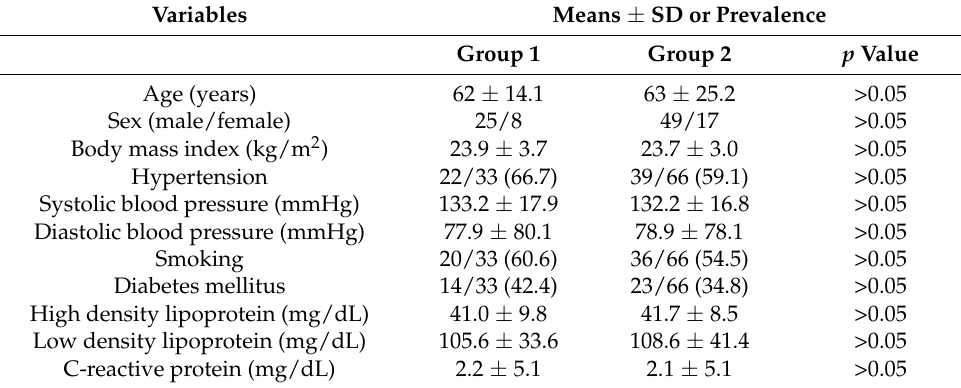
Table 1. The demographic and clinical characteristics of the patient cohort.